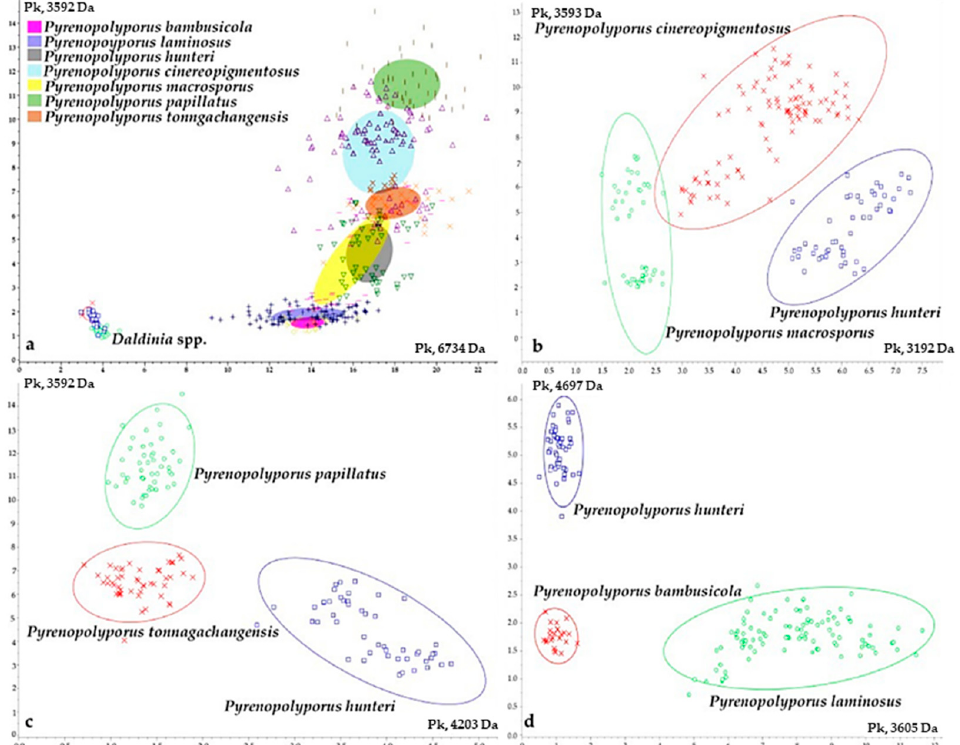
Figure 17. Principal component analysis (PCA) of the two most discriminant mass spectra peaks derived from the fungal isolates included in this study; ( a ) PCA for all Pyrenopolyporus and Daldinia strains. P. bambusicola (pink), P. laminosus (purple), P. hunteri (grey), P. cinereopigmentosus (greyish blue), P. macrosporus (yellow), P. papillatus (green), P. tonngachangensis (orange); ( b ) PCA including only P. cinereopigmentosus (red), P. hunteri (blue), and P. macrosporus (green); ( c ) PCA including only P. hunteri (blue), P. papillatus (green), and P. tonngachangensis (red); ( d ) PCA including only P. bambusicola (red), P. hunteri (blue), and P. laminosus (green).The ovals on the figures represent 95%-confidence concentration ellipses.